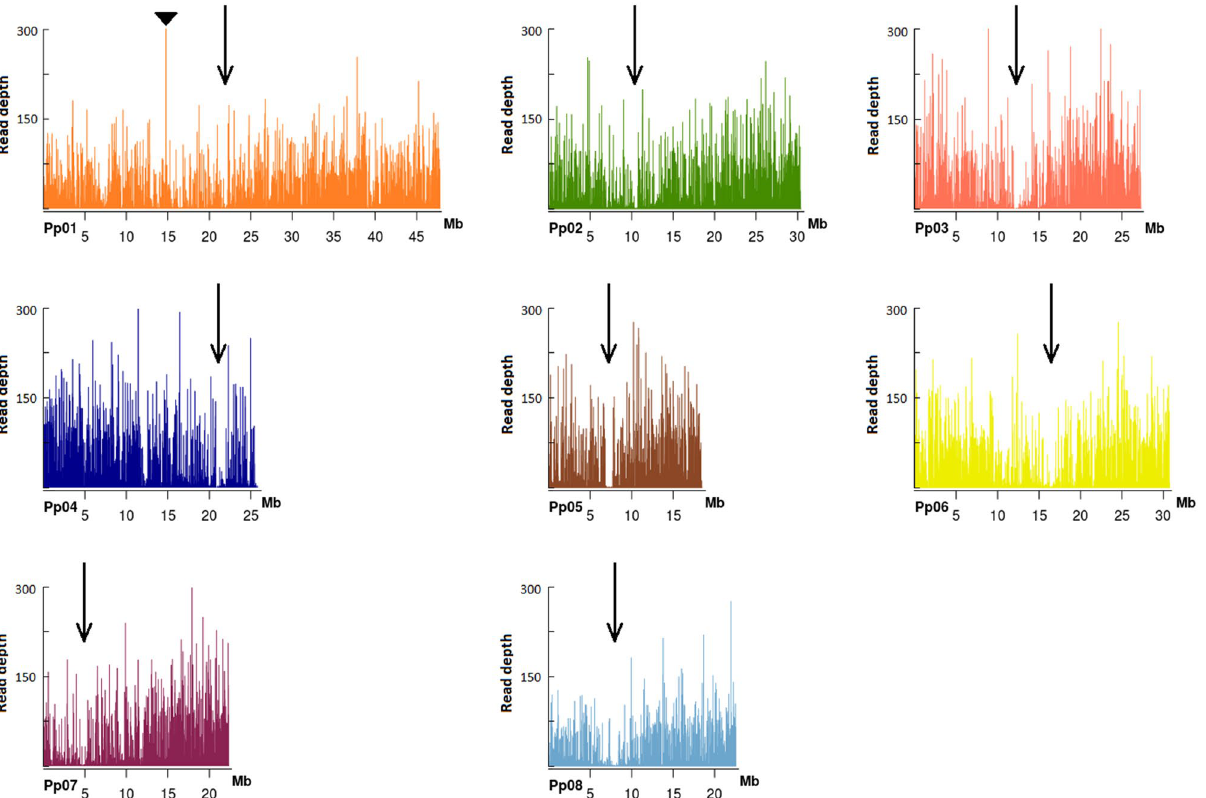
Figure 3. Reads distribution along the peach genome. The black arrows indicate the position predicted for the centromere according to Verde et al. 4 . For chromosome 1 (Pp01), the read number scale is restricted to 300 for comparison proposes. Only the bin Pp01-14,777,945–14,778,945 (indicated with a triangle) showed more than 300 reads. Supplementary Fig. S3 displays the full scale